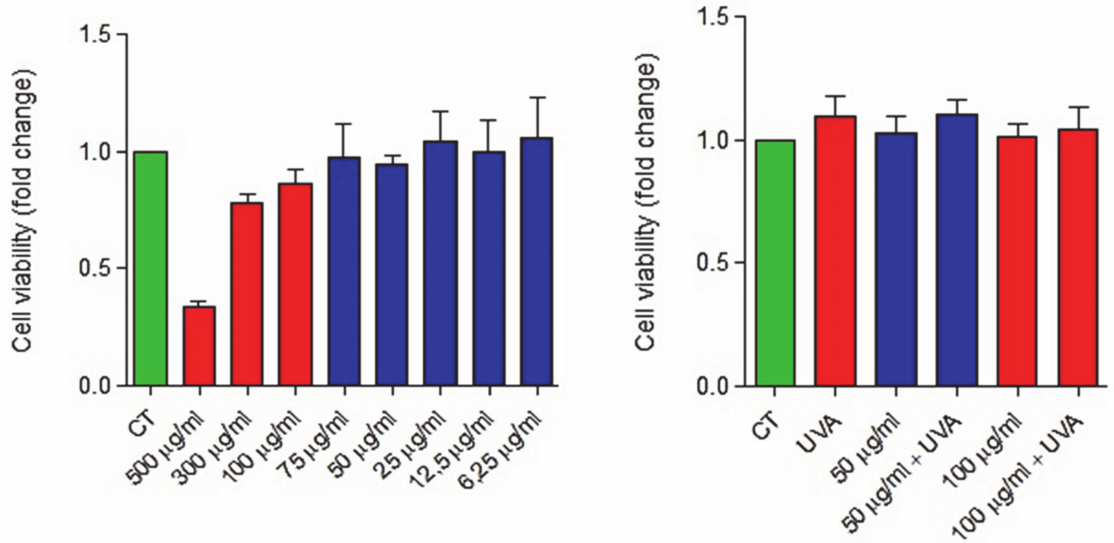
Figure 7. Biocompatibility evaluation of nCol-PL in primary skin fibroblasts cultures. Left: Cell viability (fold-change) of a primary skin fibroblasts culture after its treatment with increasing concentrations of nCol-PL. Right : Cell viability (fold-change) of a primary skin fibroblasts culture after its treatment with 100 µ g/mL and 50 µ g/mL nCol-PL in presence or absence of UVA irradiation. Bars represent mean ± standard error of the mean. The assays were performed at least twice, six replicates for each condition per